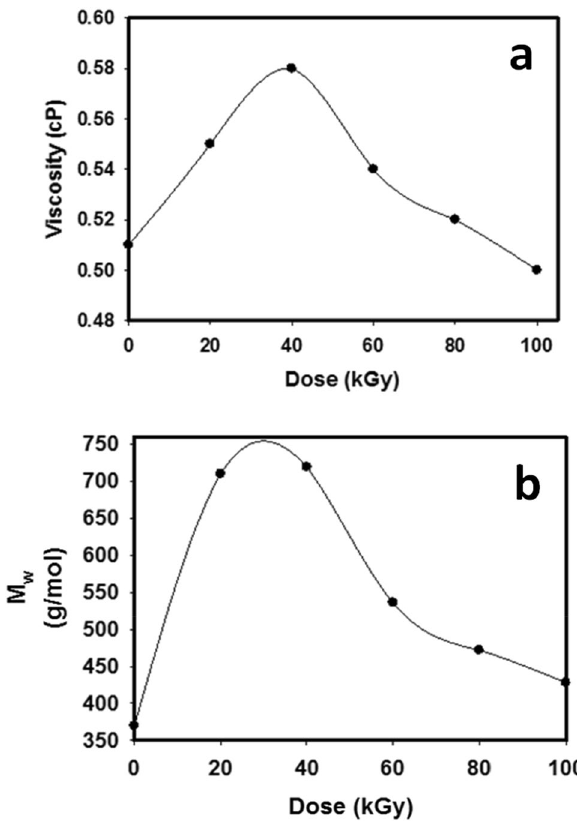
Figure 2. ( a ) The relationship between the viscosity of R-0, R-20, R-40, R-60, R-80, and R-100 samples and irradiation dose and ( b ) exposes the relationship between the M w of R-0, R-20, R-40, R-60, R-80 and R-100 samples and irradiation dose. The fixed-dose rate of ~ 0.9